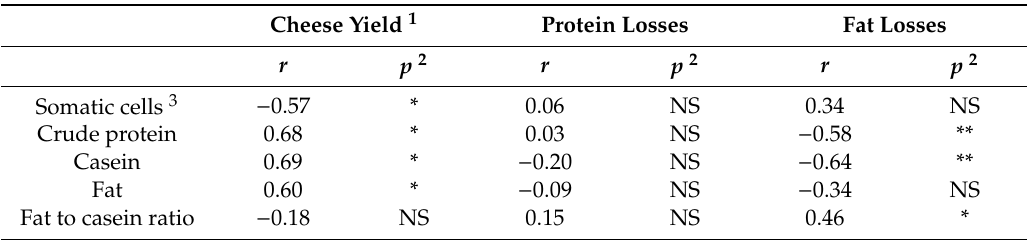
Figure 2. Cheesemaking fat losses of milk with less than 400,000 (LCC) and more than 400,000 cells / mL (HCC) (least square mean values). Classification was based on somatic cell count (SCC) of the whole evening milk. LCC and HCC means differ with a p -value ≤ 0.01. Table 3. Pearson correlation coe ffi cient ( r ) between somatic cell content of whole evening milk, cheese yield and cheesemaking losses, and between the vat milk chemical parameters, cheese yield and cheesemaking